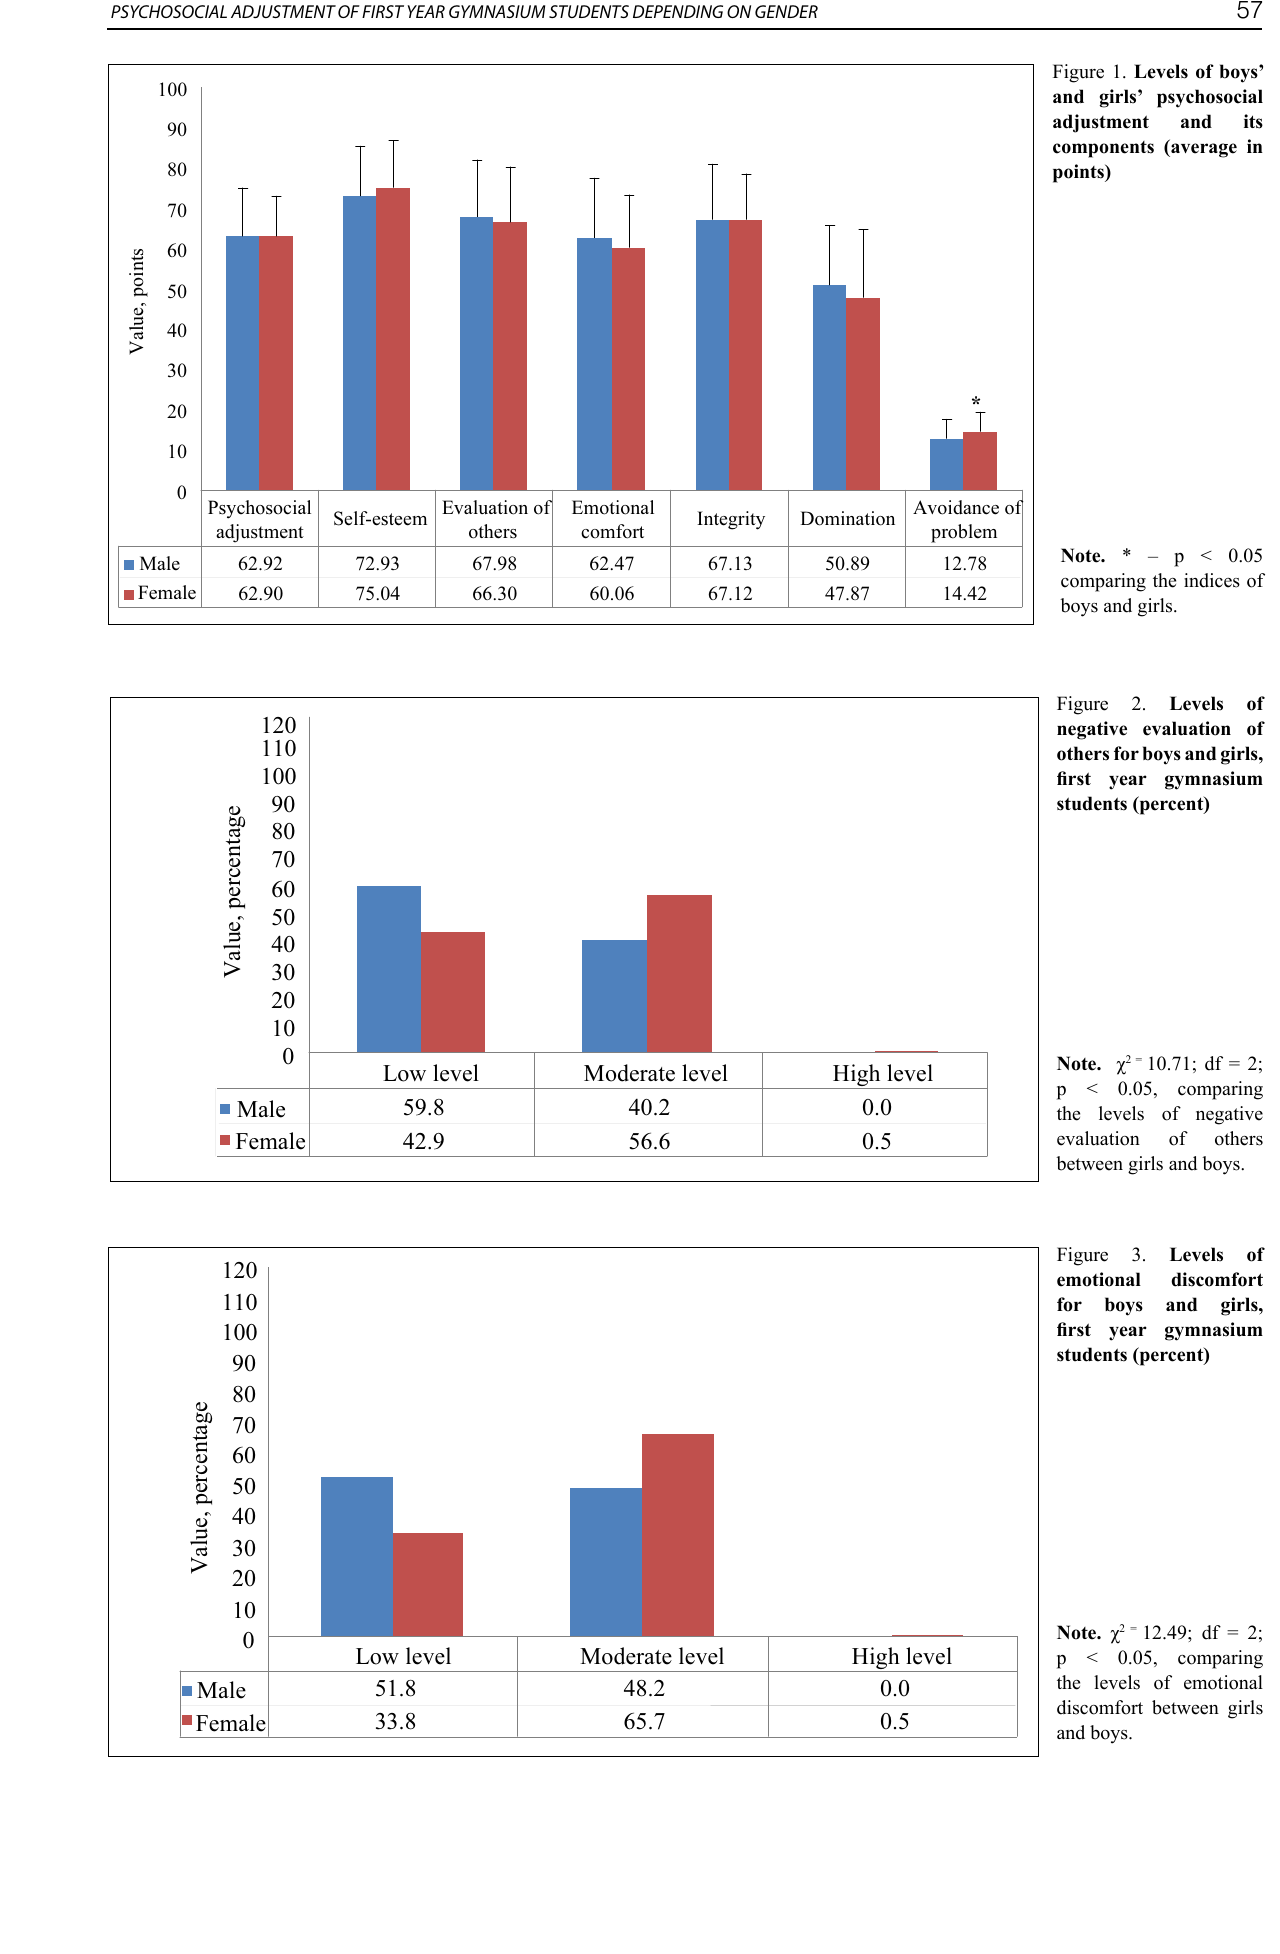
Figure 1. Levels of boys’ and girls’ psychosocial adjustment and its components (average in points)